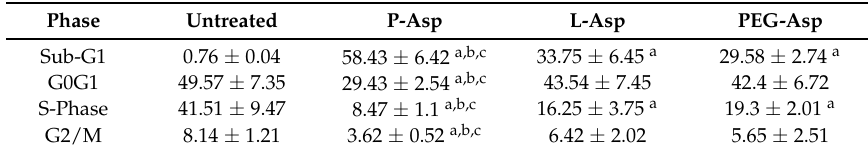
Table 1. DNA cell cycle phases of Jurkat cells treated with P-Asp, L-Asp and PEG-Asp at a concentration of 1 × IC 50 .